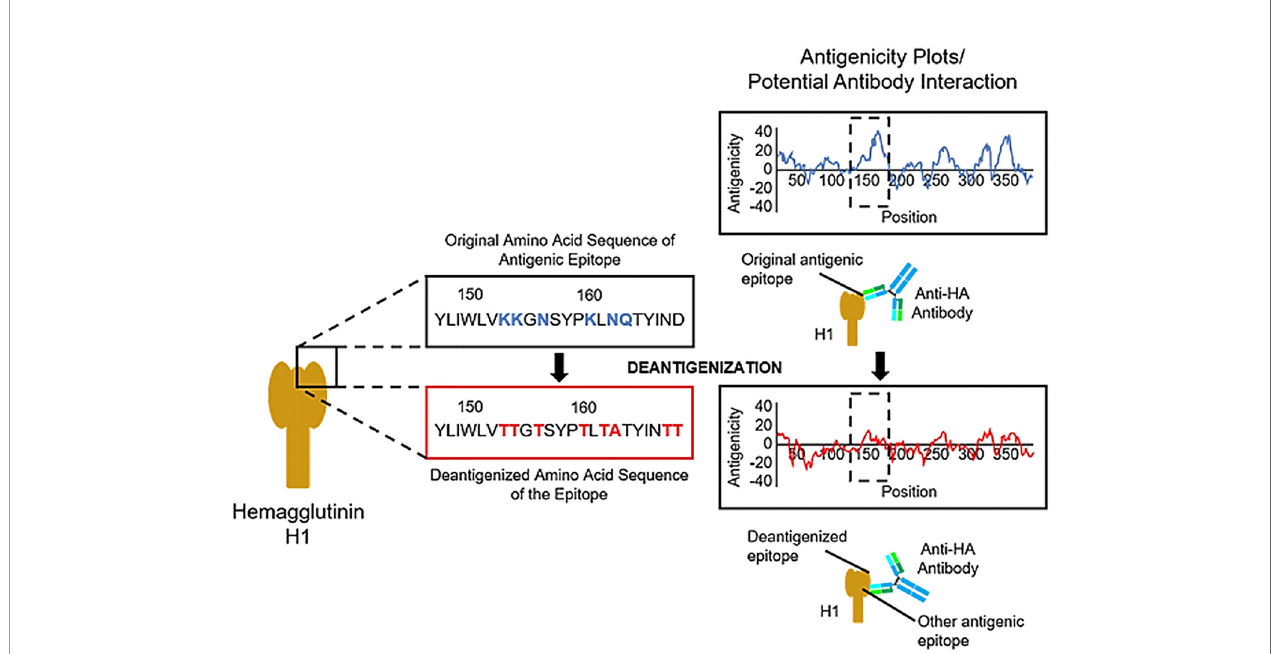
FIGURE 5 | Theoretical representation of the deantigenization of the in fl uenza H1 protein with potential application in vaccine development. Deantigenization can be done on speci fi c sites of the target protein that exhibit high solvent accessibility and antigenicity (based on calculated values), in this case an area near the receptor- binding site of the H1 protein. Amino acid substitution was introduced in this region following the replacement rule described by Padlan (305), particularly the change of Ks, Ns, and Qs to mostly Ts given the sheet con fi guration of the peptide in the area. The strict ruling on amino acid replacement renders the site less antigenic (within the broken line box in the antigenicity plot) without changing the overall three-dimensional con fi guration of the protein. By deantigenizing highly antigenic epitopes of the protein, other antigenic sites can be exposed or targeted by antigen-recognizing cells, potentially leading to the production of antibodies targeting other more conserved epitopes of the